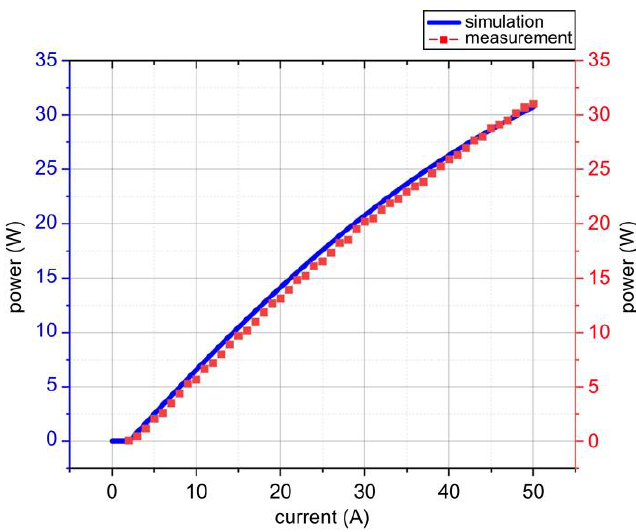
Figure 12. Comparison of PI features.